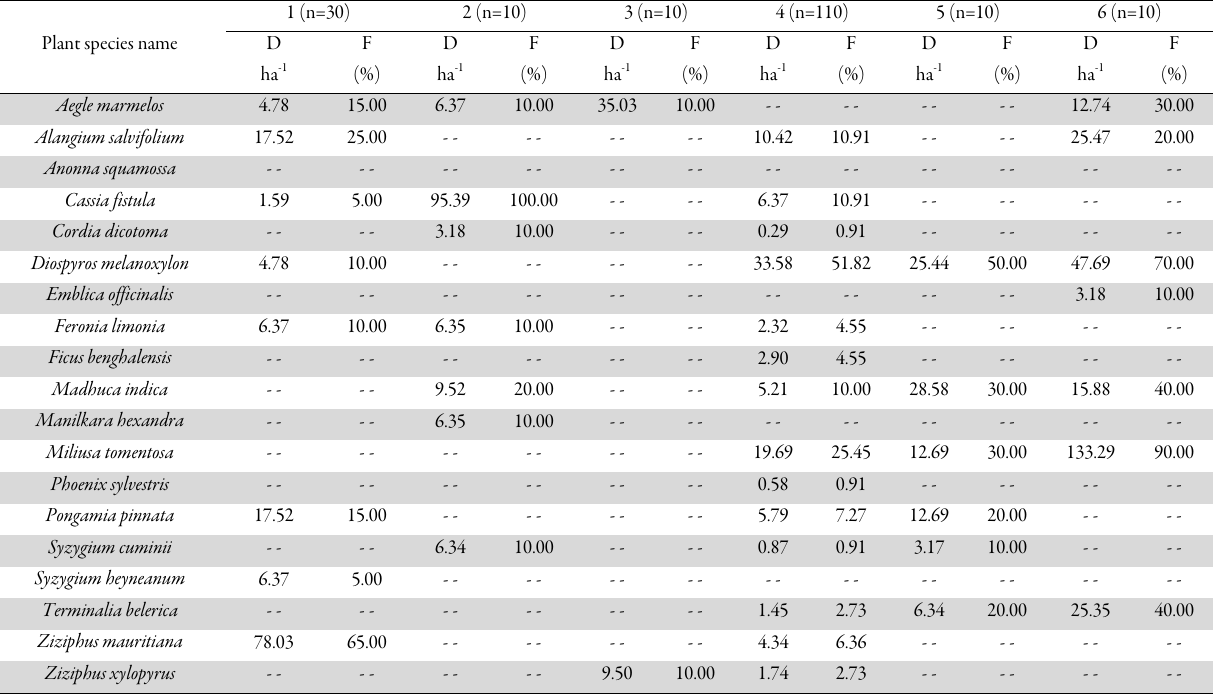
Table 2. List of tree species with their density and frequency in different forest types of study area (1- Acacia tortilis scrub forest, 2- Diospyros and Butea mixed forest, 3- Acacia catechu and Acacia tortilis forest, 4-mixed forest, 5-riverine forest, 6-teak and Miliusa mixed forest) Plant species